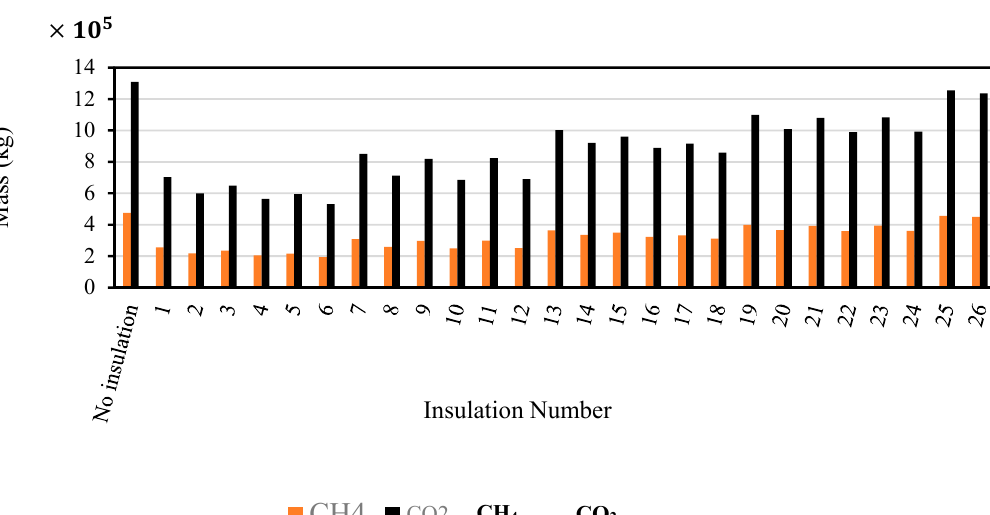
Figure 17. Comparison of the annual CO 2 emission and natural gas consumption for different insulation scenarios based on Table 5.